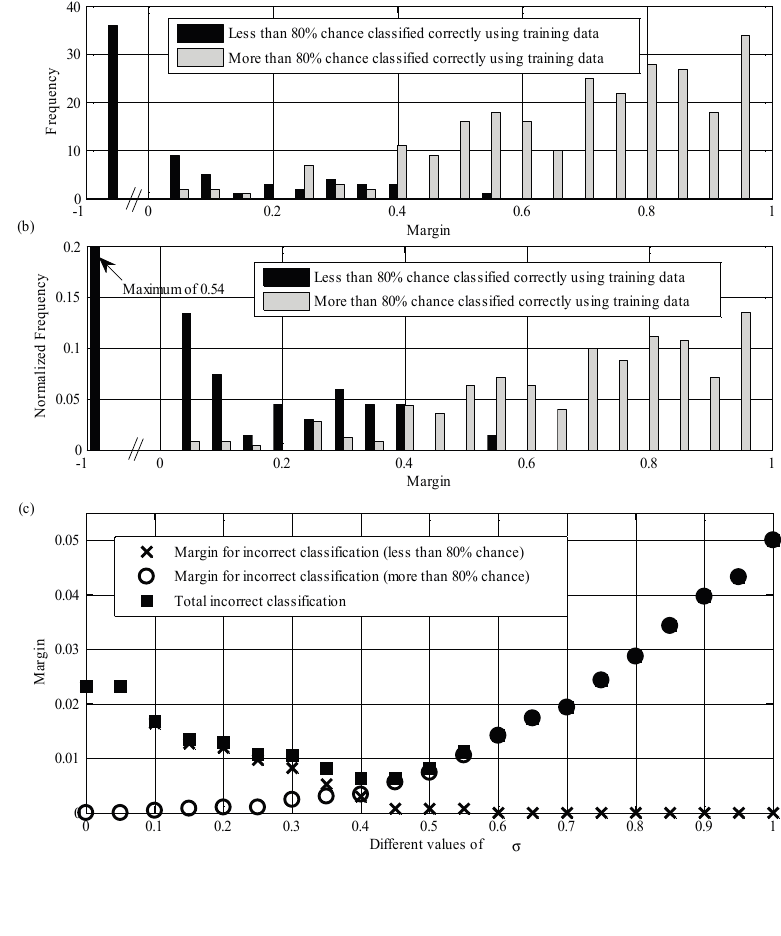
Figure 5. Frequency distribution of the LiDAR (Light Detection and Ranging) trees that are correctly classified for at least 80% (and less than 80%) with 20 randomly selected sample subsets ( a ). Normalized frequency distribution of ( a ) is shown in ( b ). Margin for incorrect classification (for more and less than 80% chance) and total margin for incorrect classification at different σ ( c